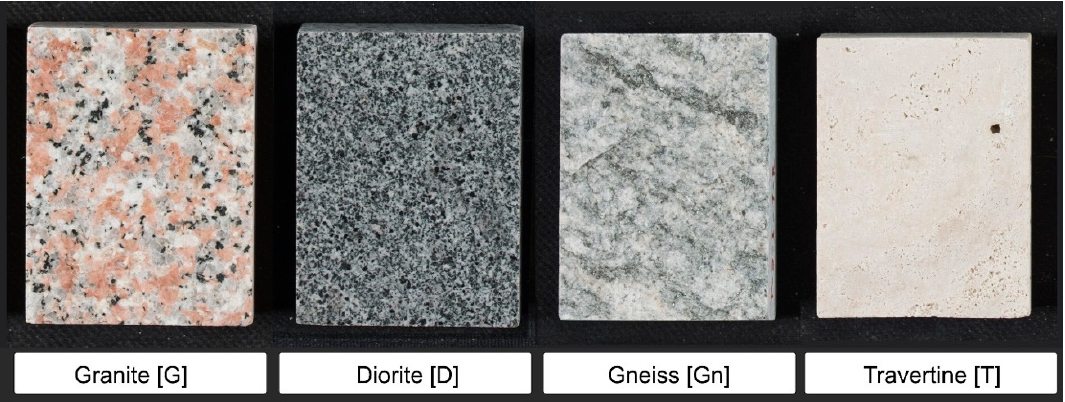
Figure 1. Digital photographs of the selected stone. Each stone shows the corresponding ID in brackets.